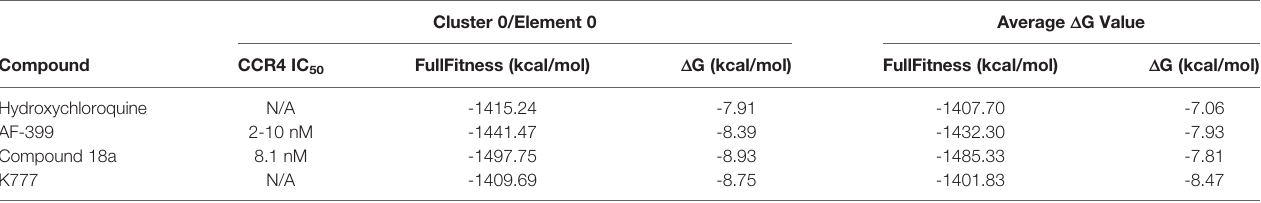
TABLE 2 | Molecular Docking Data Summary for Hydroxychloroquine and Plerixa fl or Against CXCR4. Cluster 0/Element 0